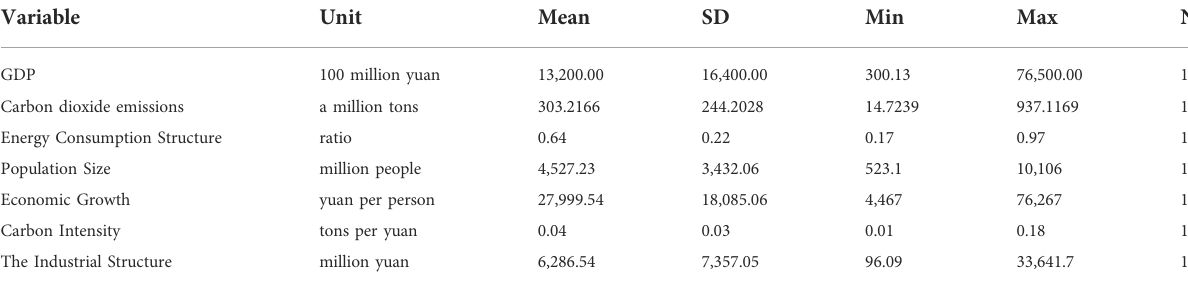
TABLE 4 Descriptive statistics of variables.